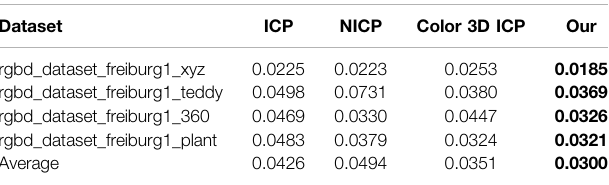
TABLE 1 | RMSE index comparison table.